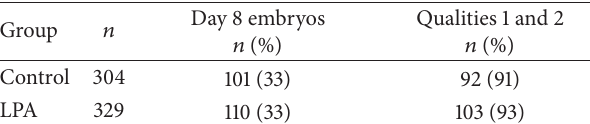
Alexa Fluor 488 donkey anti-rabbit IgG antibody (con-